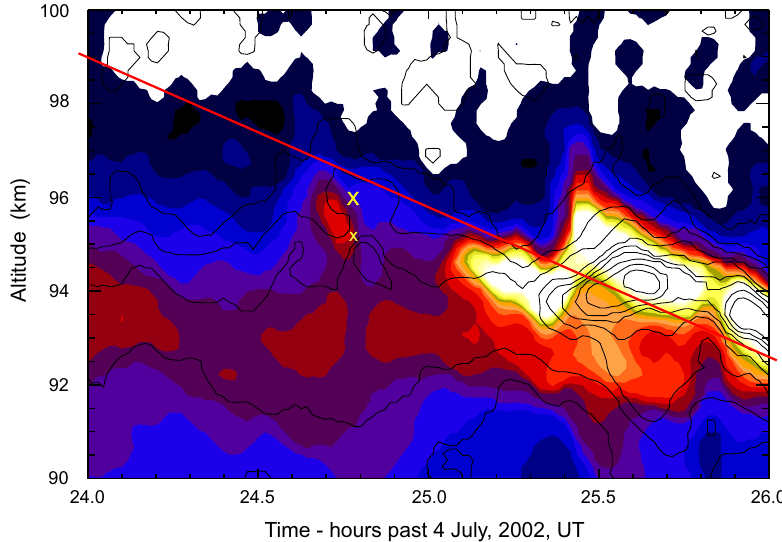
Fig. 5. The sodium mixing ratio is shown for beam 1 with the color contours and for beam 2 with the black line contours for the evening of 4/5 July 2002. The large X and small x identify the upper and lower sporadic-E layers, respectively, at the time of the in situ rocket-borne observation. The red line provides one estimate of the vertical wind velocity.